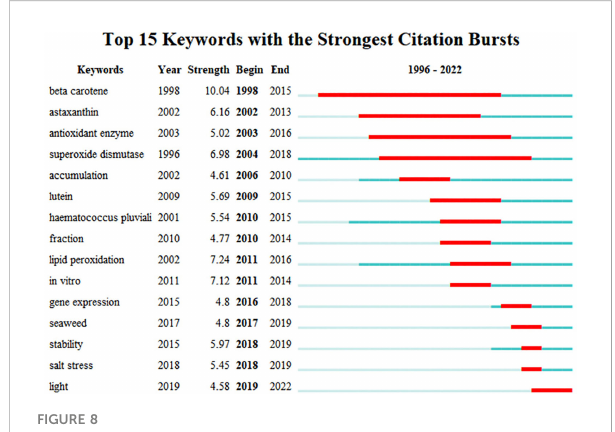
FIGURE 8 The top 15 keywords with the strongest citation